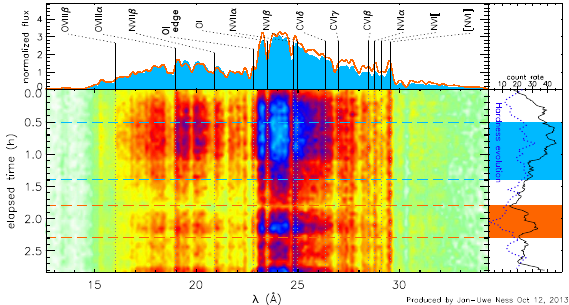
Figure 3: Dynamic spectrum for the Chandra obser- vation of RS Oph taken on day 39.7 after the 2006 out- burst. The zero-th order light curve is shown to the right with three colored shades marking time intervals from which the spectra in the top have been extracted. Line labels that belong to strong transitions are in- cluded. The central image is a brightness spectral/time map that uses a color code from light green to light blue representing increasing flux